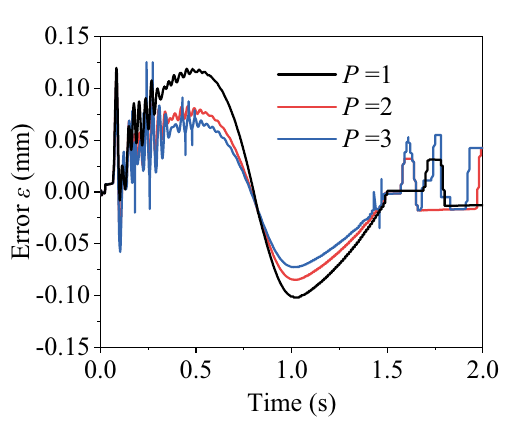
Figure 11. Curves of synchronous error.